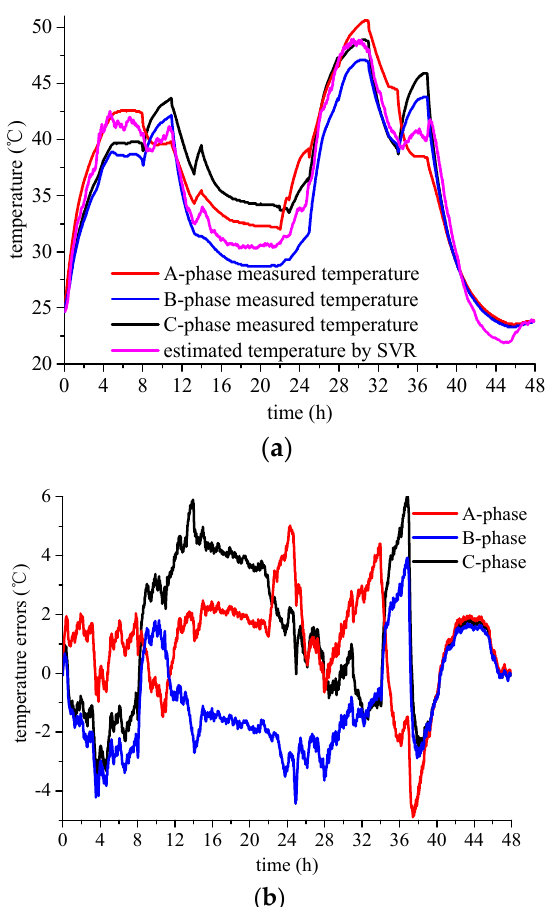
Figure 19. The measured results and estimated temperature based on SVR under unbalanced three-phase currents. ( a ) Measured and estimated temperatures; ( b ) Temperature errors.